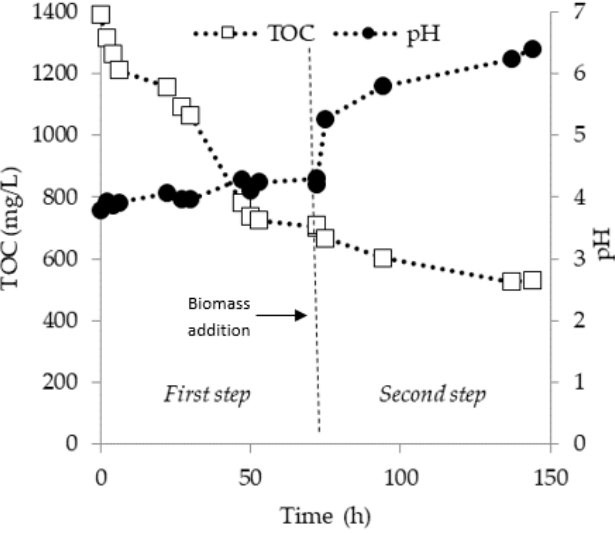
Figure 4. Aerobic biological with two-reactor system of pyrolysis wastewater with TOC initial value equal to 1400 mg/L at 30 °C.